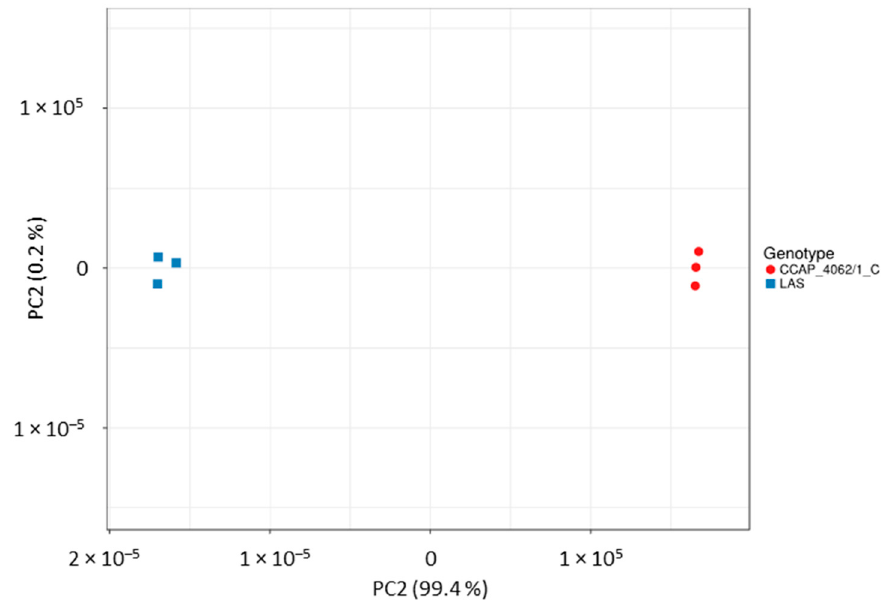
Figure A3. Principal Component Analysis showing the clustering of the RNA-seq samples (red circles = wild type CCAP 4062/1, blue squares = LAS mutant) using the TMM normalized expression values. The percentage of explained variance is indicated in parenthesis. LAS and CCAP_4062/1 replicates are indicated as blue squares and red circles, respectively.